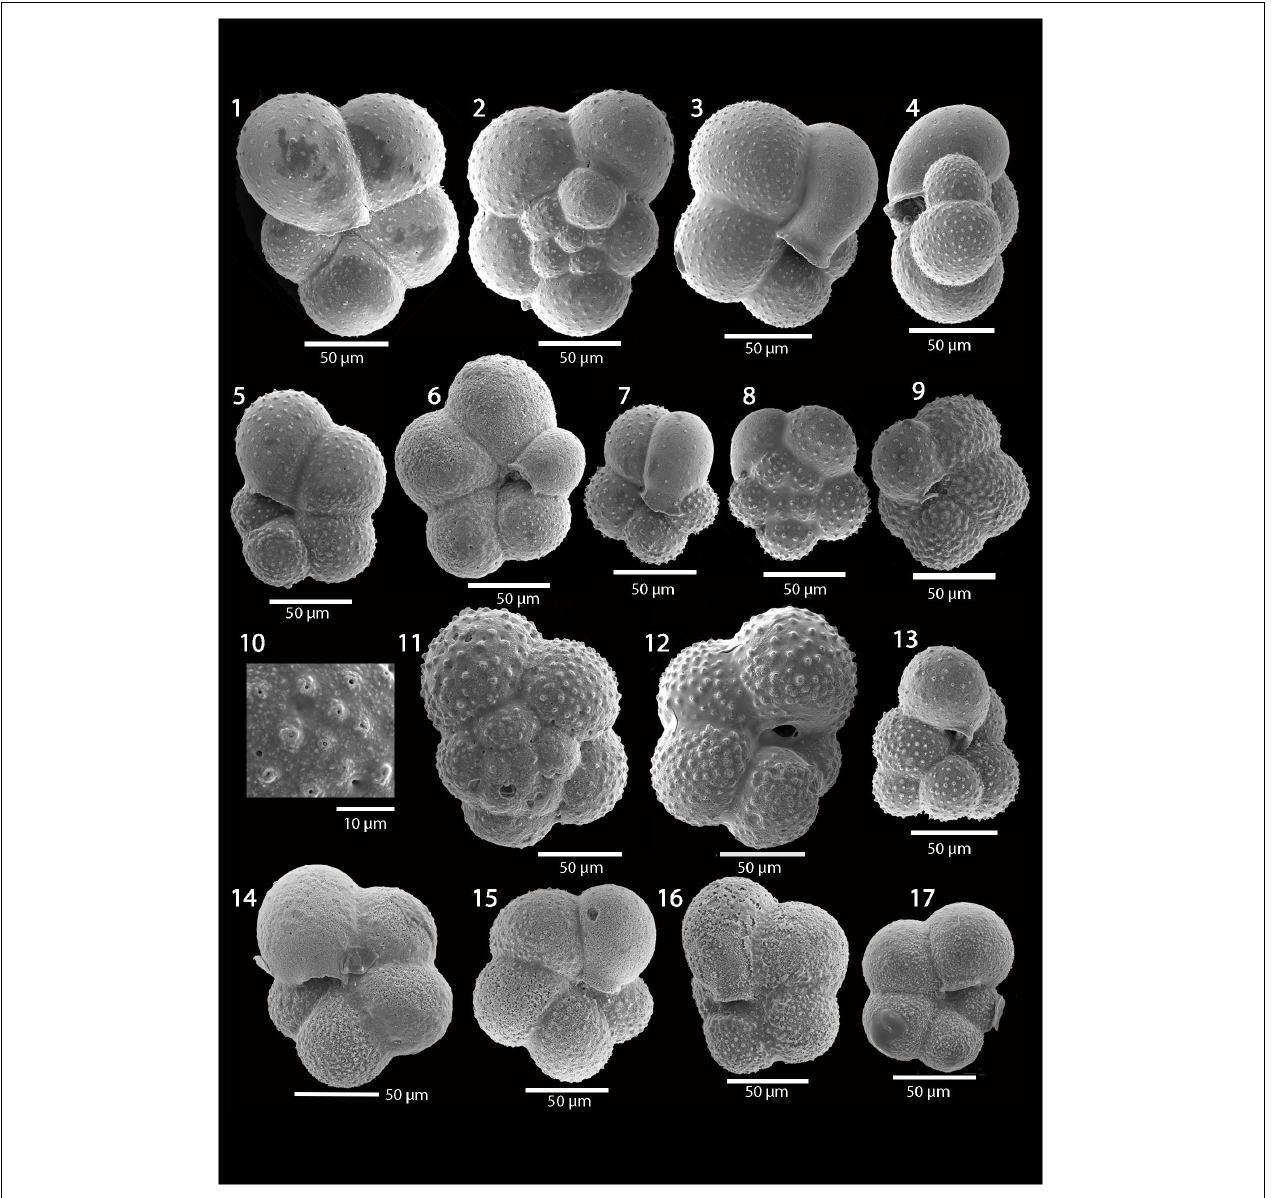
FIGURE 8 | SEM images of Turborotalita from the Lomonosov Ridge off Greenland in the Arctic Ocean. Images 1–13; Examples of T. quinqueloba from Sample LOMROG12-PC07, section 3, 114–116 cm (3.46 mbsf), probable MIS 9. Note these specimens lack the outer crust typical for this species but often have